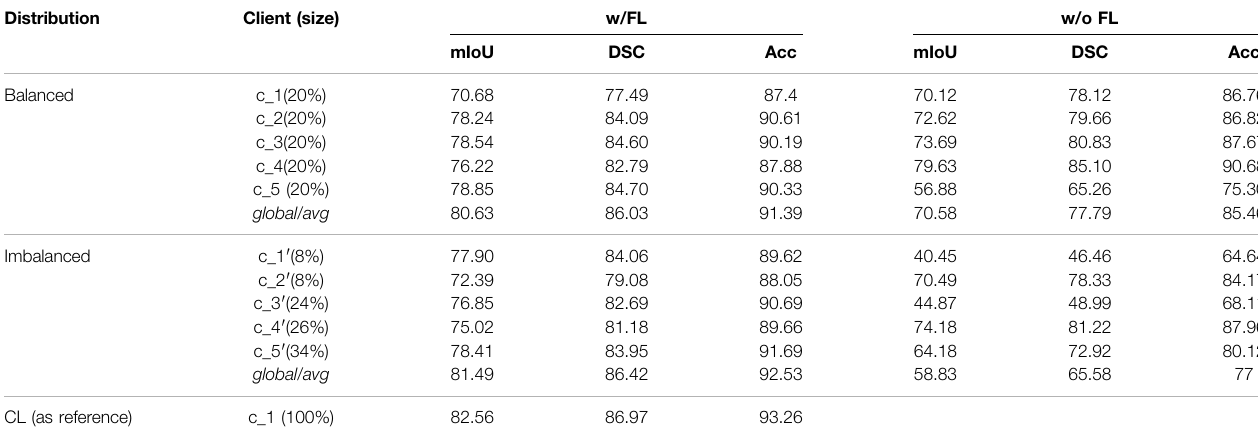
TABLE2| Performanceof fi veclients ’ localmodelswhenepoch=100. “ Size ” meanstheproportionofthedatasetforeachclient;w/FLmeansclientsarewithintheFedTSeg framework;w/oFLmeansclientsperformpurelylocaltraining; global denotestheglobalmodelafteraggregation;and avg calculatestheaveragetestingaccuracyof fi ve local models without the FL framework.